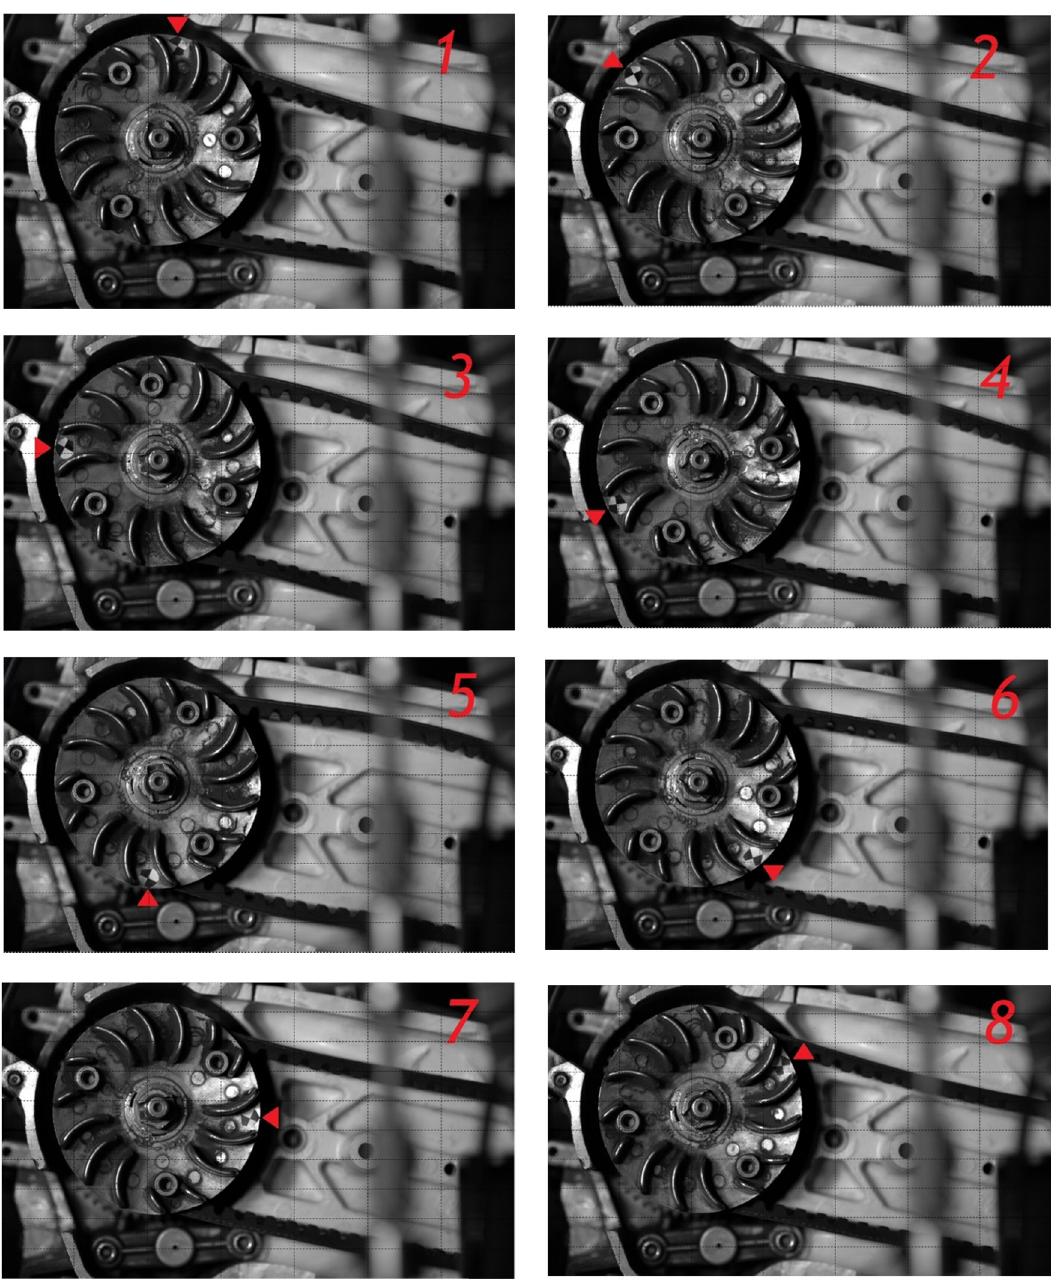
Figure 4: Belt vibration during single crankshaft revolution ( engine rotational speed: 4,560 rpm ) : upper fragment – tight belt side, lower fragment – slack belt